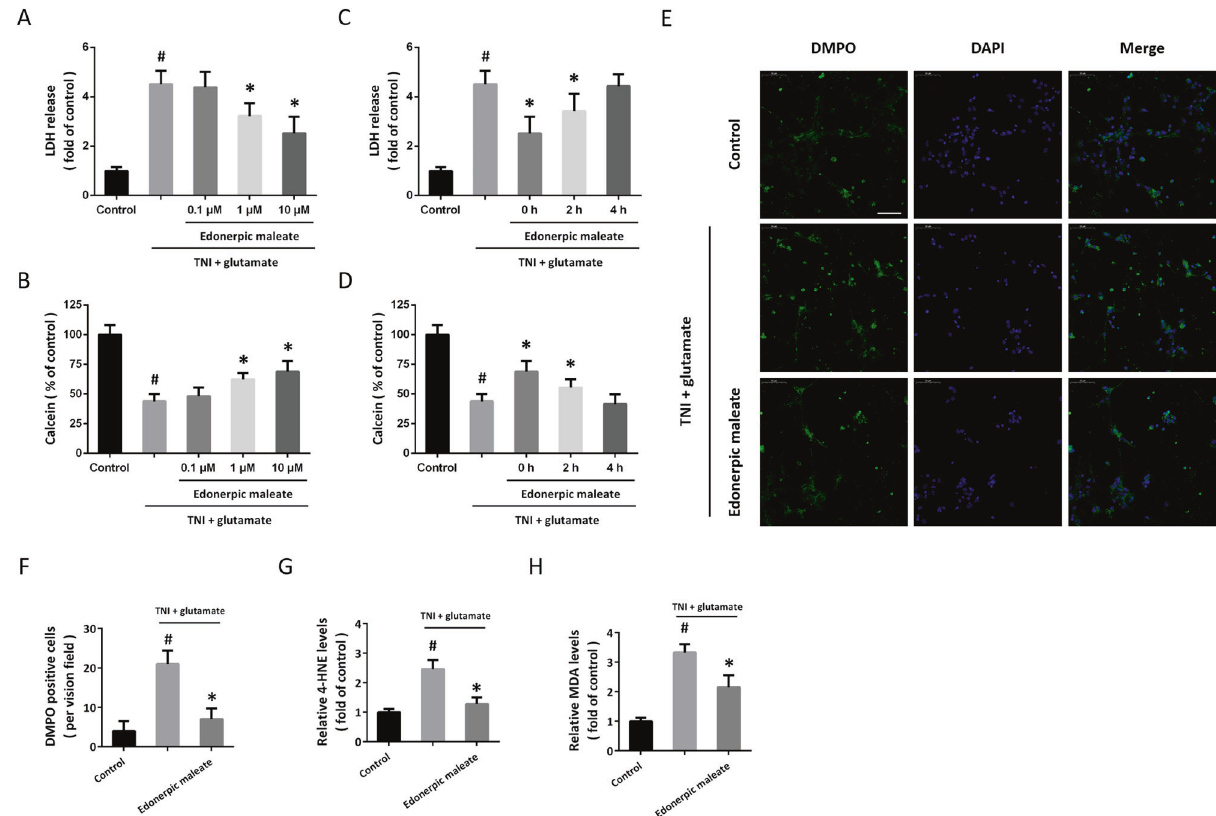
Fig. 1 Edonerpic maleate attenuates neurotoxicity and oxidative stress following neuronal trauma. A LDH release assay was used to investigate the effect of edonerpic maleate on toxicity. B Calcein signal assay was used to investigate the effect of edonerpic maleate on cell viability. C , D LDH release assay ( C ) and calcein signal assay ( D ) were used to determine the therapeutic time window of edonerpic maleate. E , F Immunostaining ( E ) and quanti fi cation ( F ) showed that edonerpic maleate inhibited the expression of DMPO following TNI and glutamate treatment. G , H Edonerpic maleate reduced the levels of MDA ( G ) and 4-HNE ( H ) following TNI and glutamate treatment. Scale bar, 50 μ m. Error bars indicate SEM. # p < 0.05 vs. Control. * p < 0.05 vs . TNI +